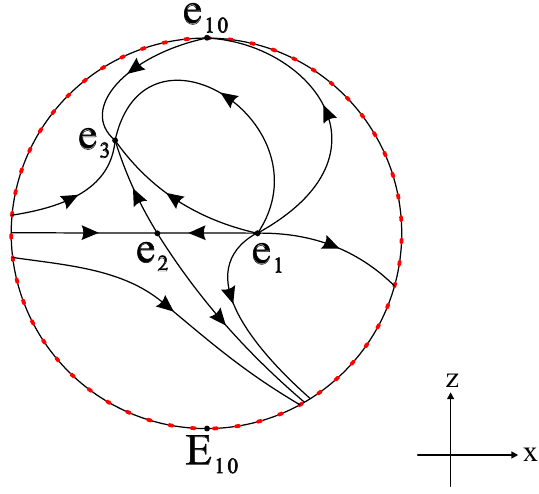
Figure 3. Phase portraits on y =